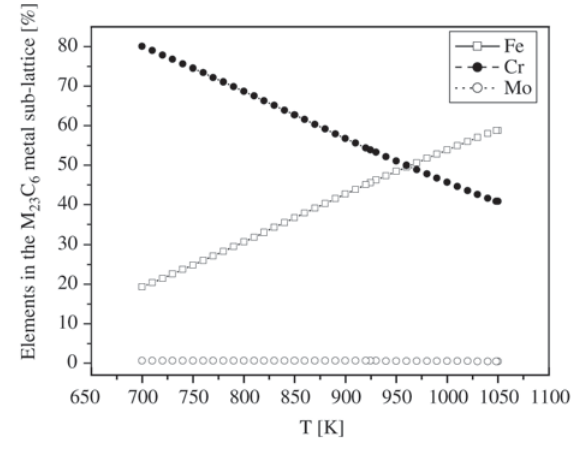
Figure 4. Driving Forces for thermodynamically stable carbides in a 2.25Cr-1.0Mo steel.